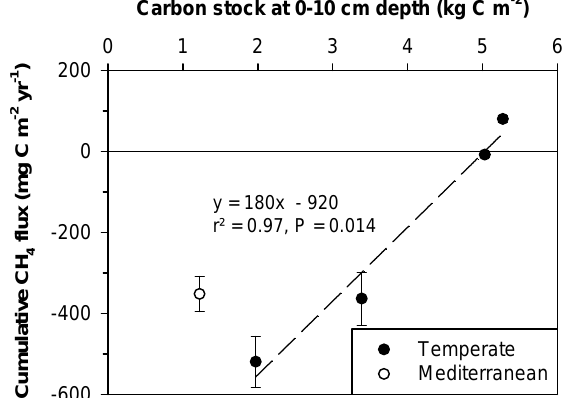
Fig. 3. Annual CH 4 flux as a function of carbon stock in the 0– 10cm soil layer at five shrubland sites (means ± SE). A linear re- gression line was fitted to data from the four temperate shrubland sites. plots (Fig. 6b). At the site level, however, reduced soil mois- ture caused by drainage or drought consistently reduced the N 2 O efflux ( P = 0 . 0005). According to differences of least squares means, this was especially pronounced for drainage at the Estonian peatland EE-Män and for drought at the Dutch shrubland Oldebroek (NL-Old) (site × treatment; P = 0 . 034). The warming treatment had no effect on N 2 O fluxes ( P = 0 . 47) (Table